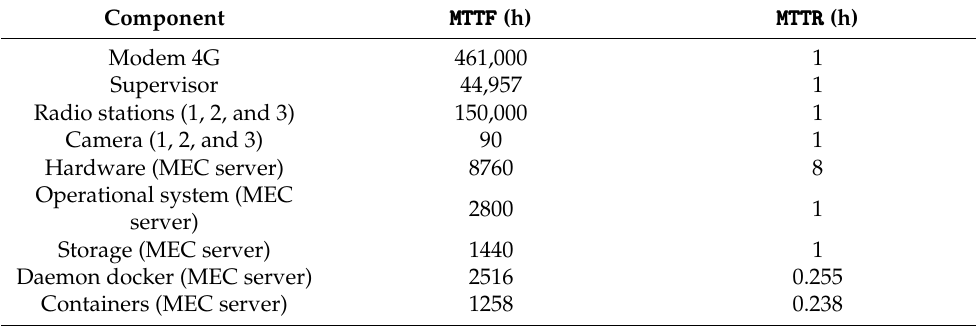
Table 7. Model input parameters.